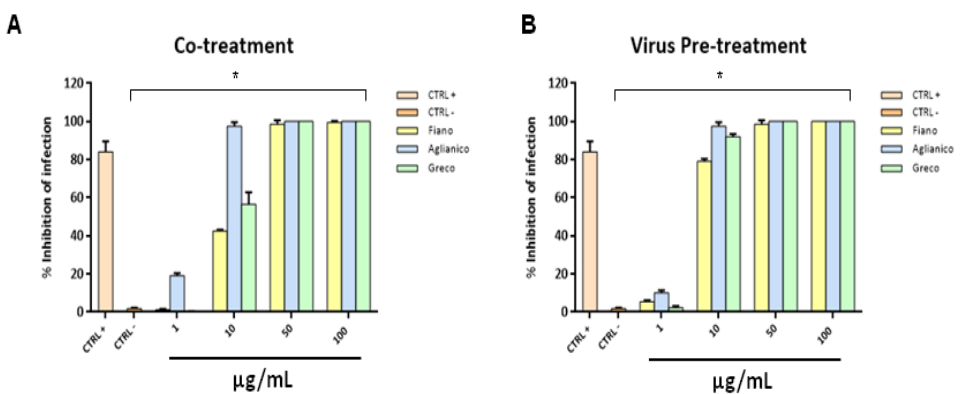
Figure 7. Antiviral activity against HSV-2 of extracts at pH 7.00. Co-treatment ( A ) and virus pre-treatment ( B ) assays were performed. Extracts inhibited the early stages of infection, directly blocking the viral particles. Statistical differences were evaluated via two-way ANOVA; a value of p ≤ 0.05 was considered significant, with * p ≤ 0.0001.